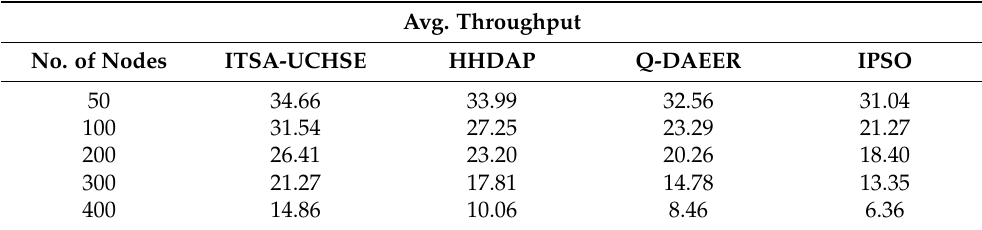
Table 5. ATHRO analysis of ITSA-UCHSE system with existing approaches under distinct nodes. Avg.